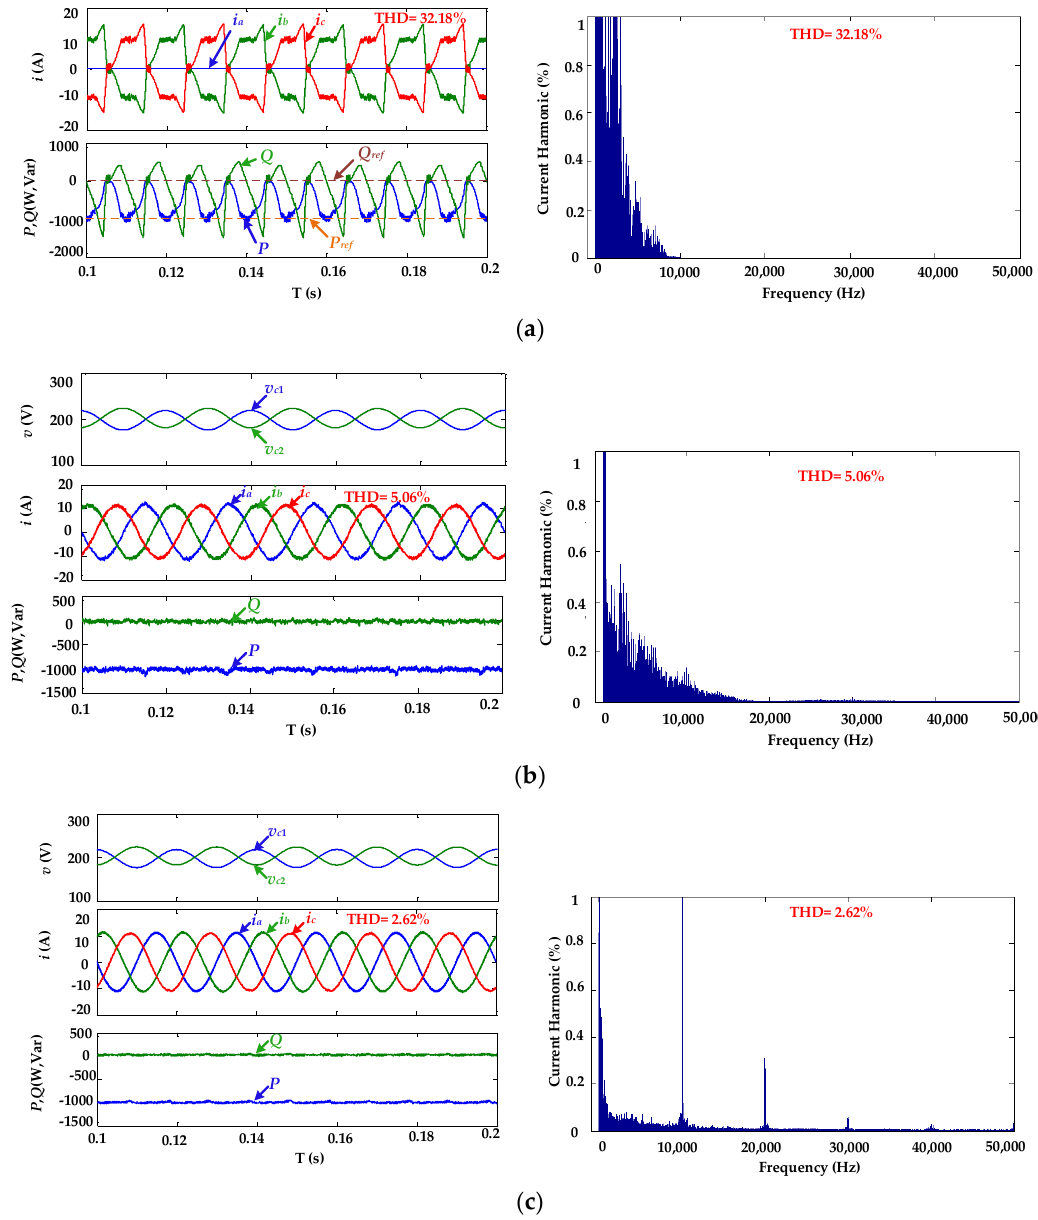
Figure 8. Simulation results with a Phase A fault in rectifier mode. ( a ) MPDPC for TPSS. ( b ) MPDPC for TPFS. ( c ) Proposed CF-MPDPC for TPFS.